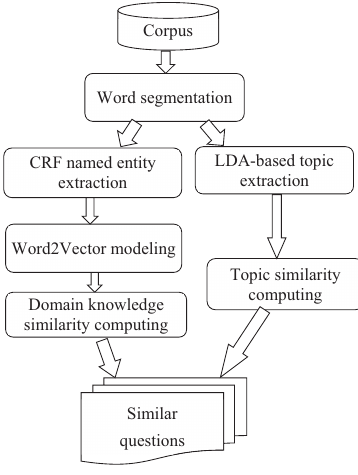
Figure 1. Overview of the proposed